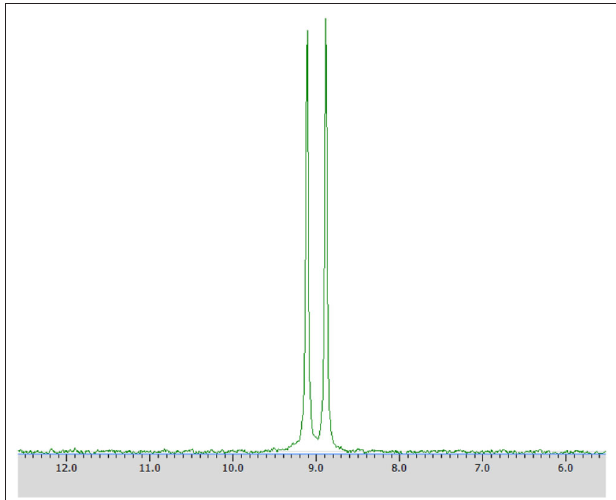
FIGURE 2 | 31 P NMR spectrum of racemic 1-amino-1-(2-thienyl)methylphosphonic acid (substrate 1) with the addition of α -cyclodextrin (as chiral solvating agent) at pH 7.